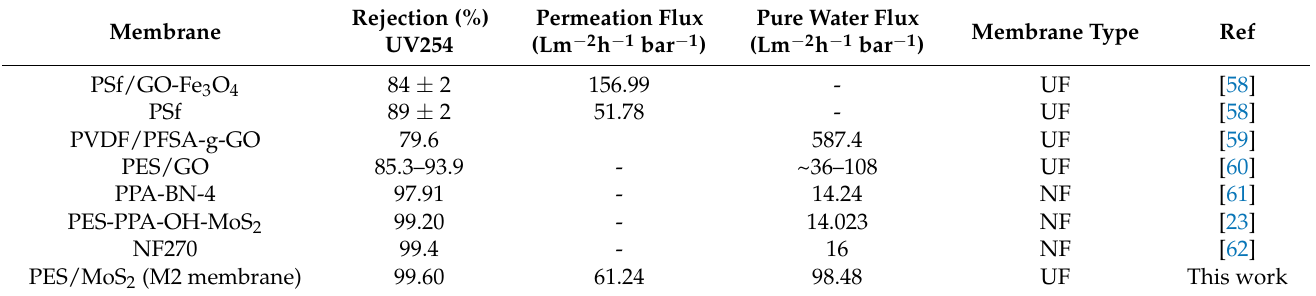
Figure 10. HA rejection of prepared membranes with different concentrations of MoS 2 . Table 3. Comparison of the HA separation performance of the PES/MoS 2 membrane with some other membranes.